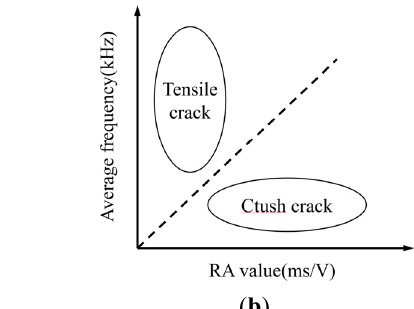
Figure 8. Relationship between AE characteristic parameters and loading time: ( a ) URC-0, ( b ) URC- 5, ( c ) CRC-5, ( d ) JRC-0, ( e ) JRC-5, ( f ) JRC-10.